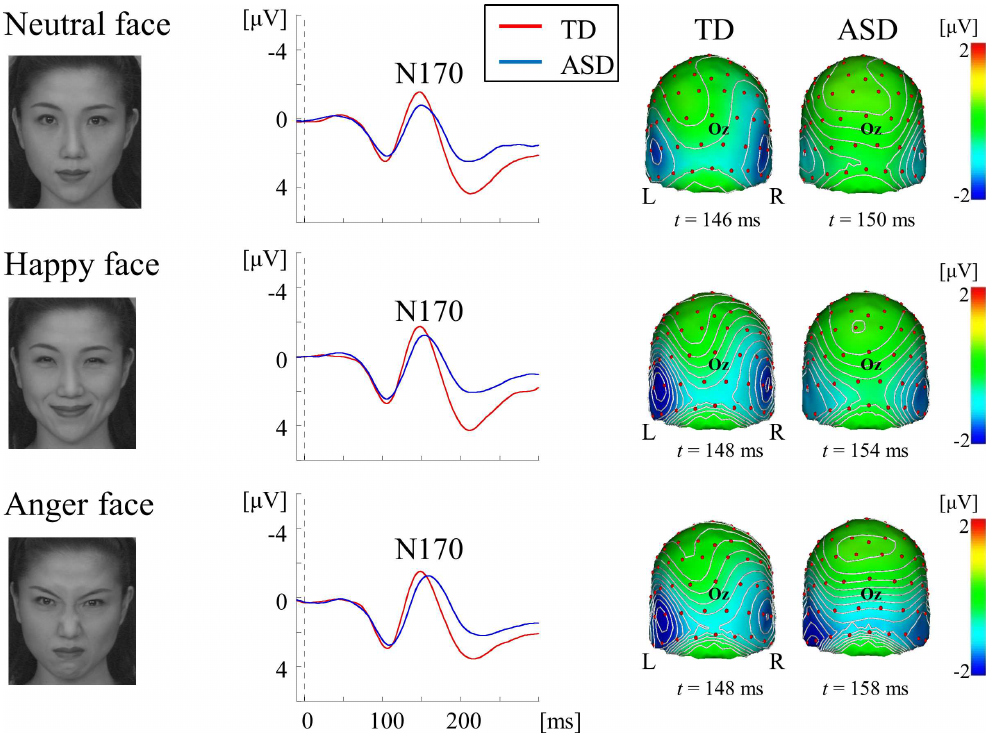
Fig 3. VEPs for face stimuli at the right occipitotemporal ROI in each group. Grand-averaged waveforms illustrate that N170 was evoked as a major componentfor all facial expressions. Scalp topography shows that N170 was distributedover the bilateraloccipitotemporal area with right